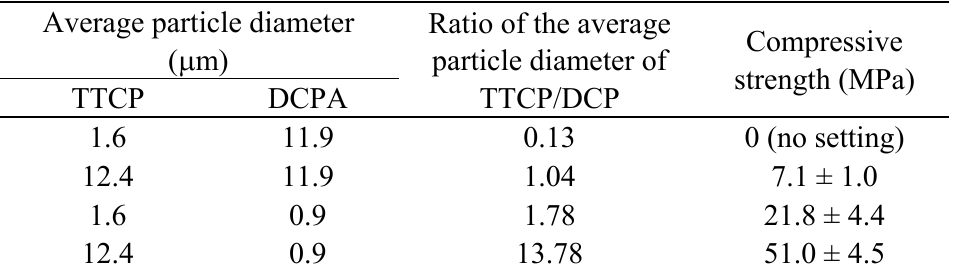
Table 2. Effects of particle size on the compressive strength of calcium phosphate cement consisting of tetracalcium phosphate and dicalcium phosphate anhydrous [13].